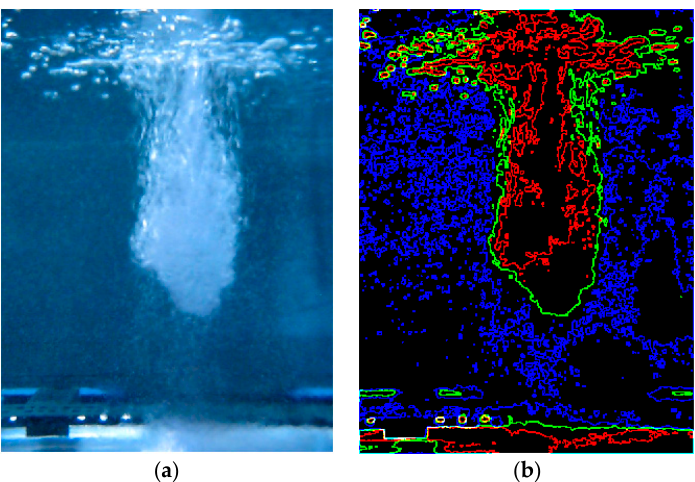
Figure 4. Example of plume width determination using image processing: ( a ) original image from experimental run ( ∆ s = 40 psu and L j = 15 cm); ( b ) filtered image using the Sobel filter to exaggerate the edges in each color. The width of the bubble plume in this figure was determined as 10.0 cm, and the bubble penetration depth was 25.3 cm .